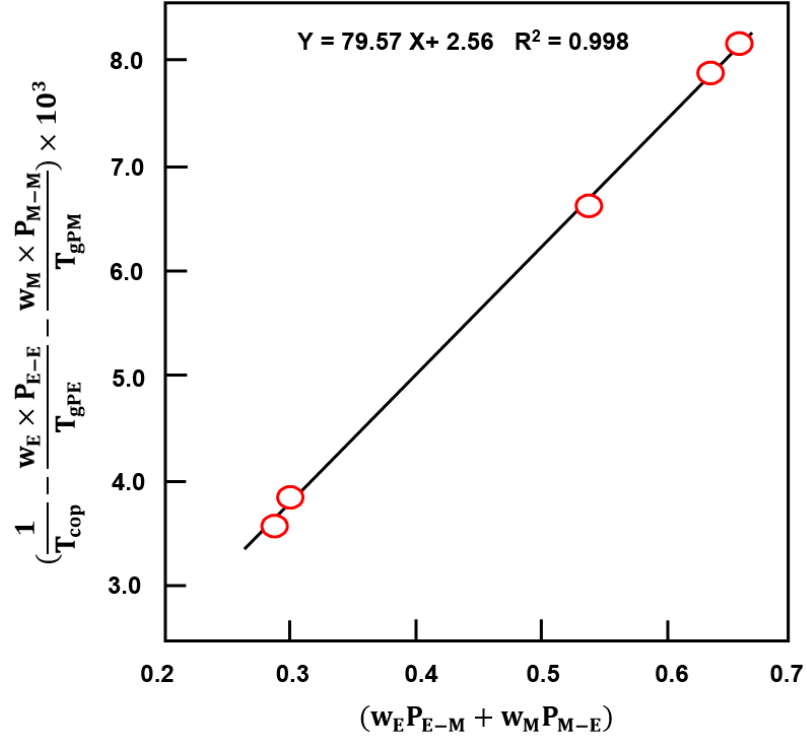
Figure 14. Linearized expression of Johnston’s treatment to the EUGMA–MMA copolymer system.